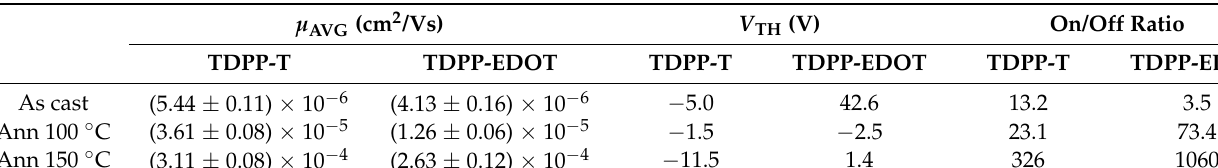
Table 2. OTFT device performance of TDPP-T and TDPP-EDOT .